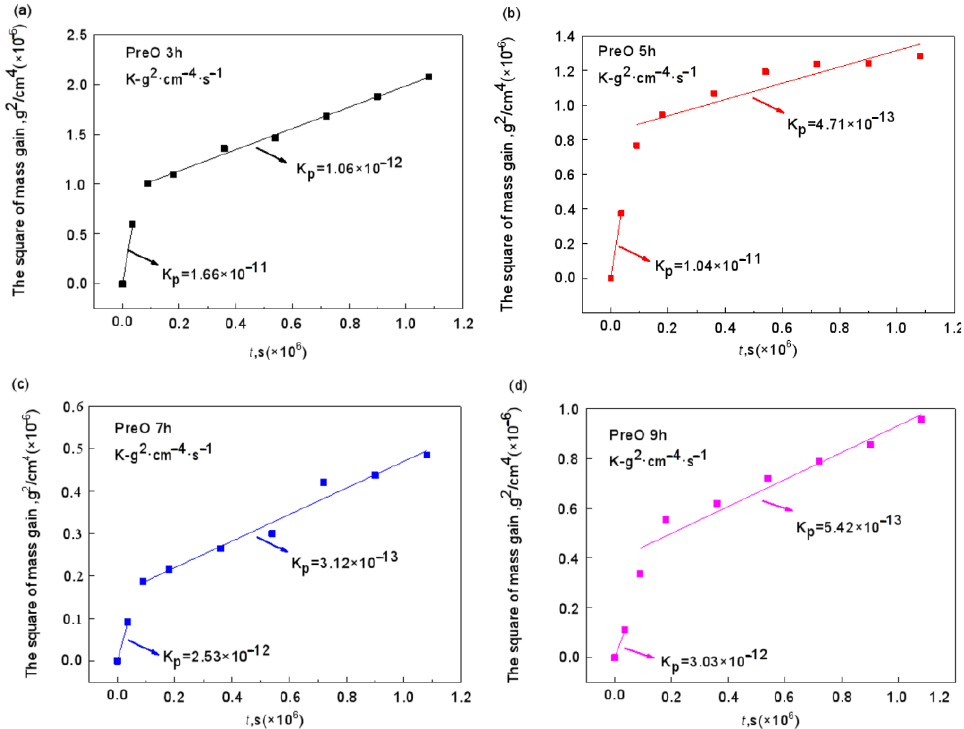
Figure 24. Parabolic rate constant of constant temperature oxidation of Al-Si coating at 1000 °C for 300 h with different pre-oxidation times: ( a ) 3 h; ( b ) 5 h; ( c ) 7 h; ( d ) 9 h.